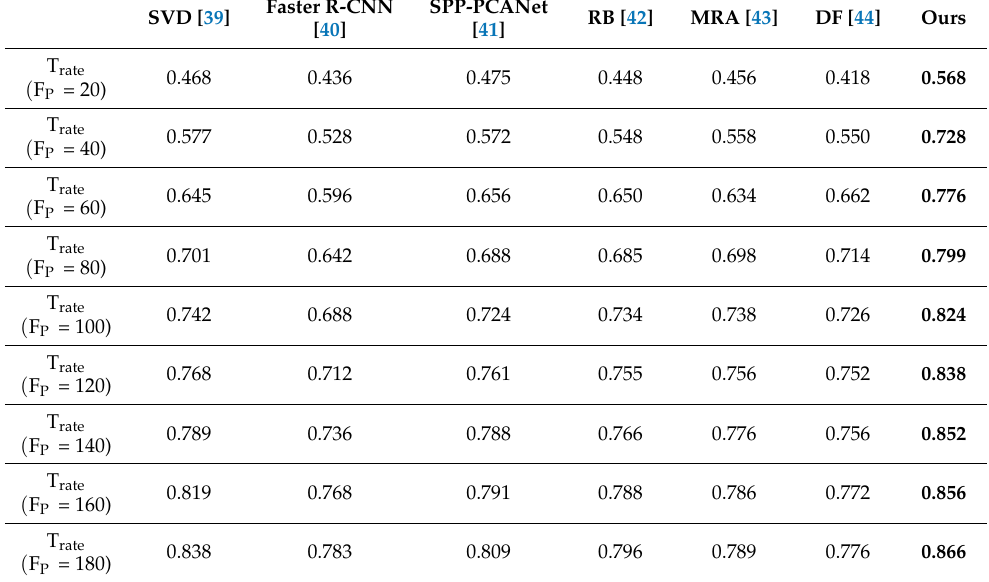
Table 5. True–False-positives quantitative data under all